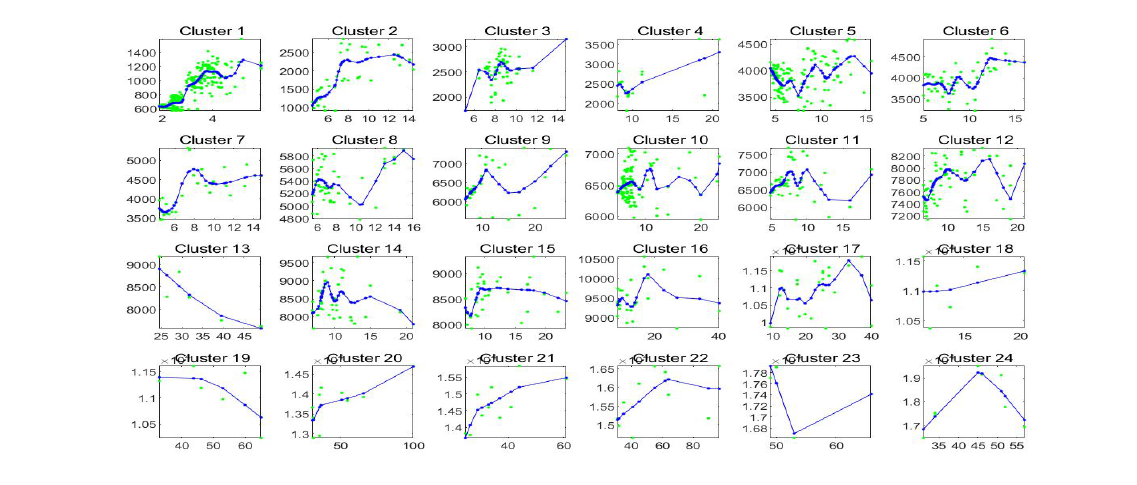
Figure 14. The fitted BitCoin time series (blue color) is obtained from L 2 -norm iF-transform function applied to the data-set ( GT 100 t , BitCoin t ) ; the observed BitCoin t values are green and the observed GT 100 t values are